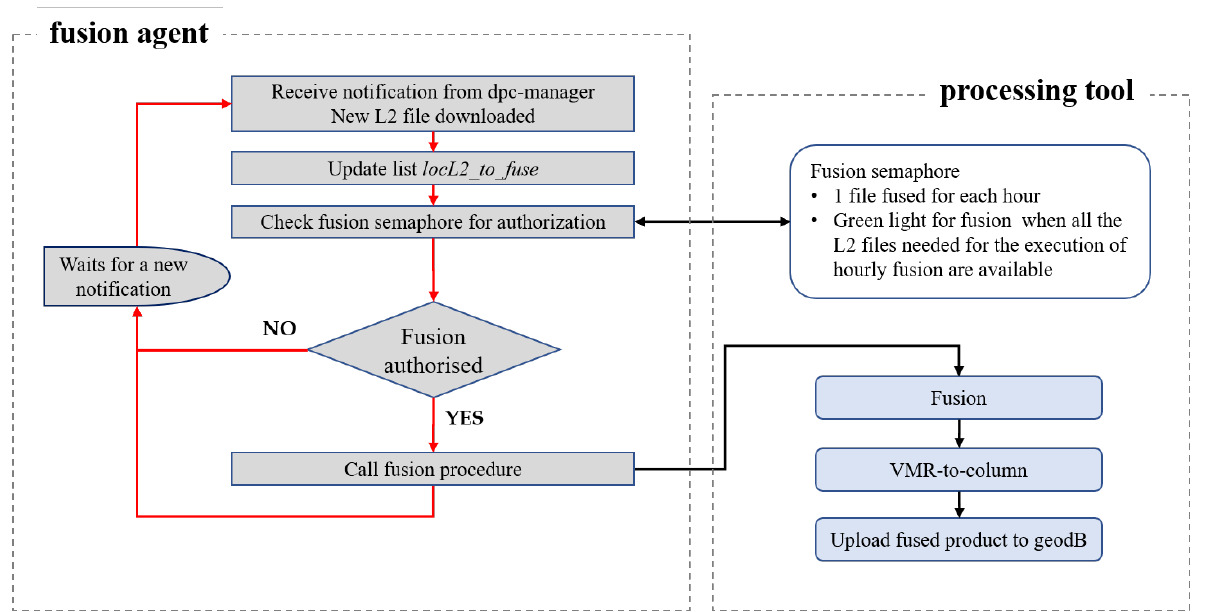
Figure 7. High level flow chart of Fusion